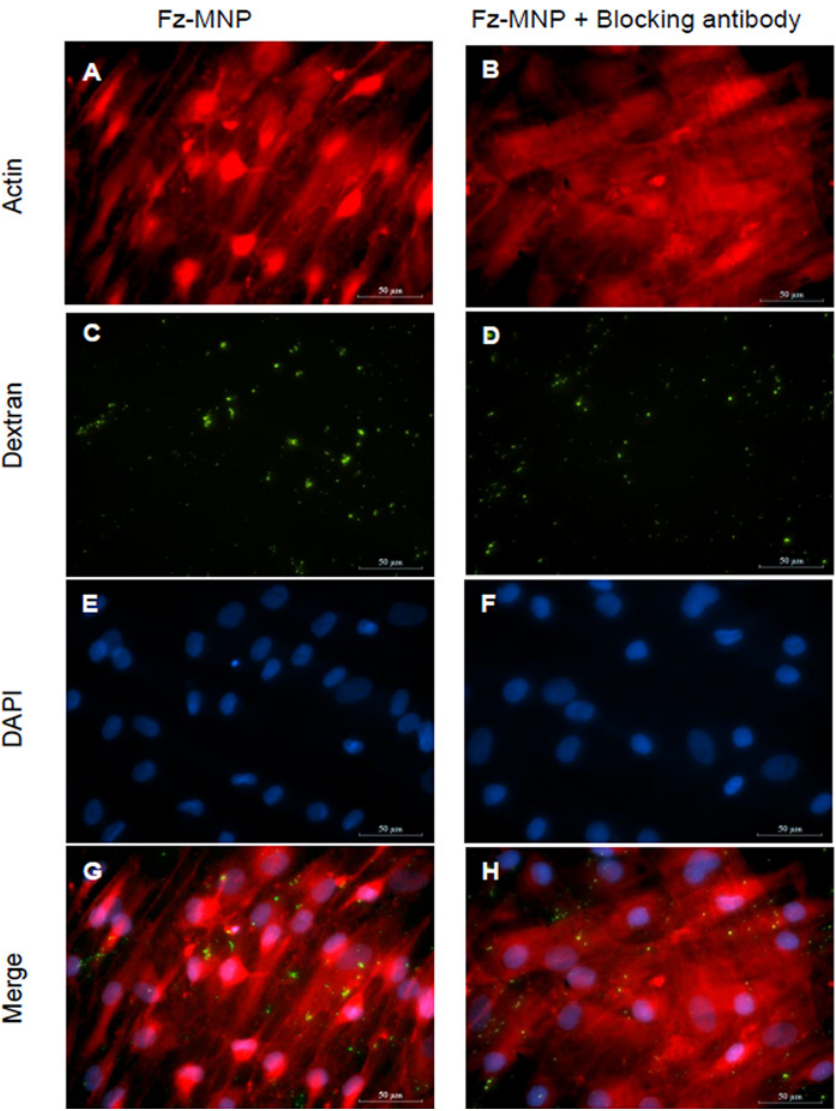
Cytoskeleton was visualised using Phalloidin (A, B), Anti-Dextran (C, D) was used to visualise Fz-MNP. Cell nuclei are shown by DAPI staining (E, F). Merged images are shown in G, H. Scale bar = 50 μ m. Images representative of n =